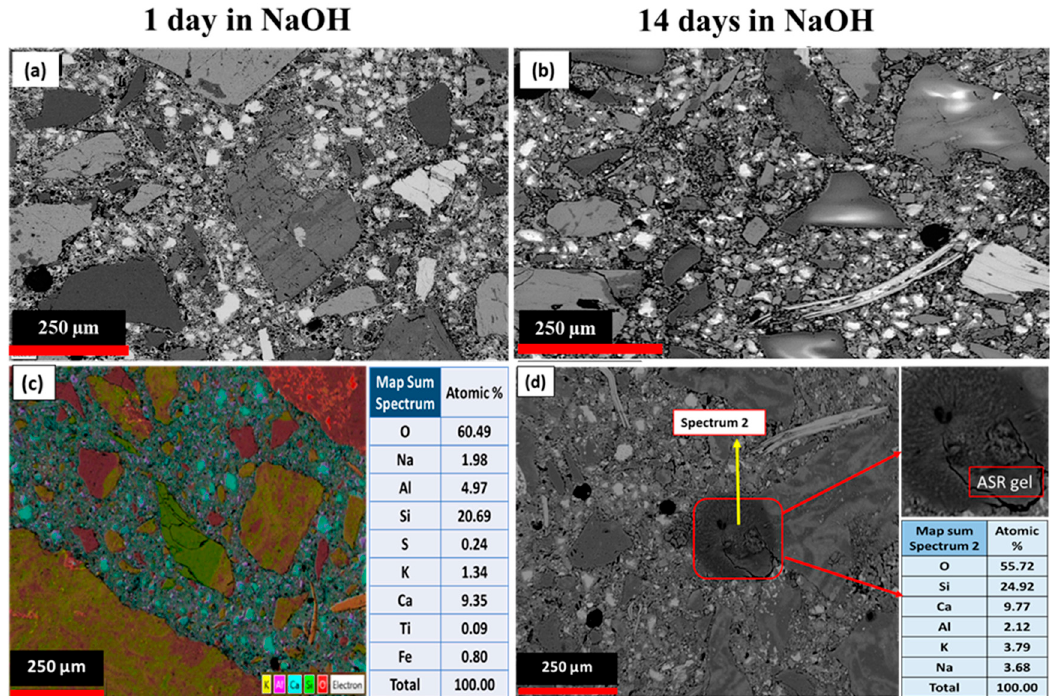
Figure 5. Accelerated mortar bar test results (ASTM C 1260).